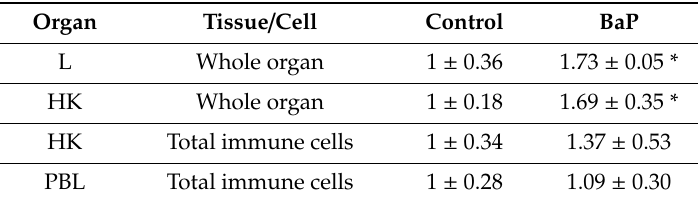
Figure 4. ahr2 α gene expression levels of liver (L), head kidney (HK), immune cells isolated from head kidney and immune cells isolated from peripheral blood (PBL) are shown. The immune cells were not sorted but the total population was used. The RT-qPCR data were calculated using the 2 − ( ∆∆ ct) method. Gene expression levels of the liver of control rainbow trout were set to be 1 and the mRNA expression levels of the other treatments were compared to the control liver (note: log scale on the top x -axis). Data represent mean values ± SD from 10 fish per treatment. PBL = peripheral blood immune cells. Table 2. Induction of ahr2 α mRNA transcripts in organs and cells of BaP-exposed rainbow trout relative to ahr2 α transcript levels in the respective organs and cells of control rainbow